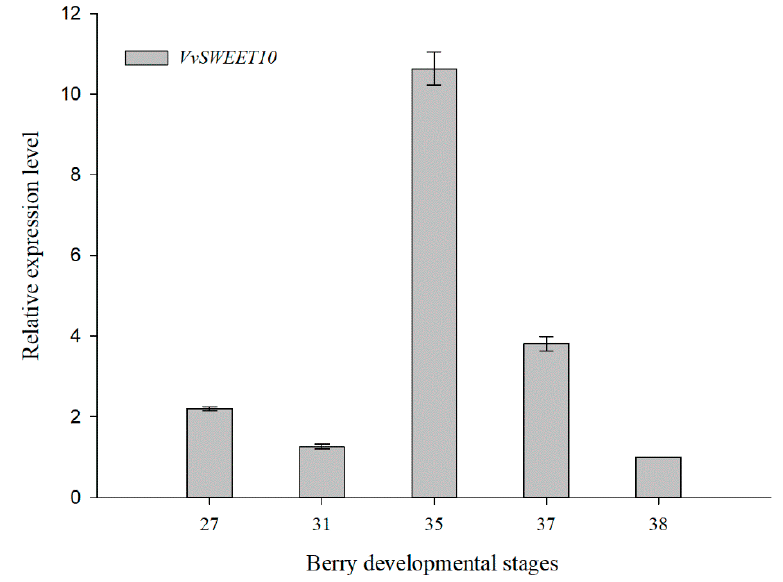
Figure 2. Developmental expression patterns of VvSWEET10 in grapes. The five developmental stages (i.e., E-L stages 27, 31, 35, 37, and 38) of the berry were used for qRT-PCR. The results are presented as means ± SD (n = 3).